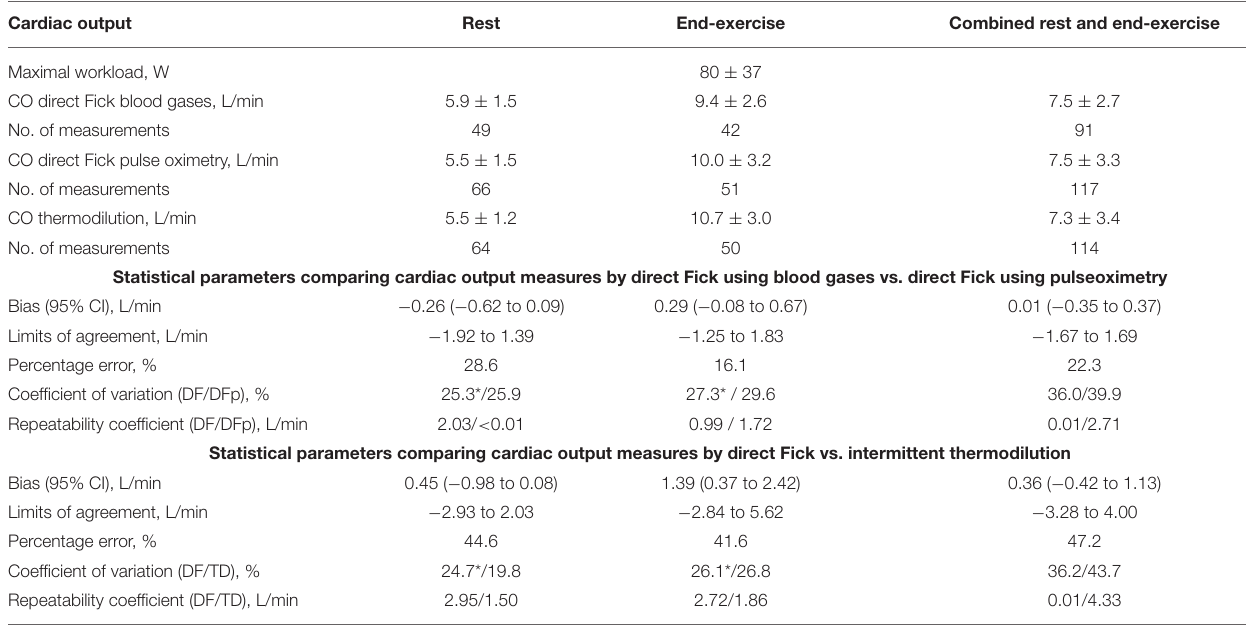
TABLE 2 | Mean cardiac output (CO) and statistical parameters at rest, end-exercise, and both combined. Cardiac output